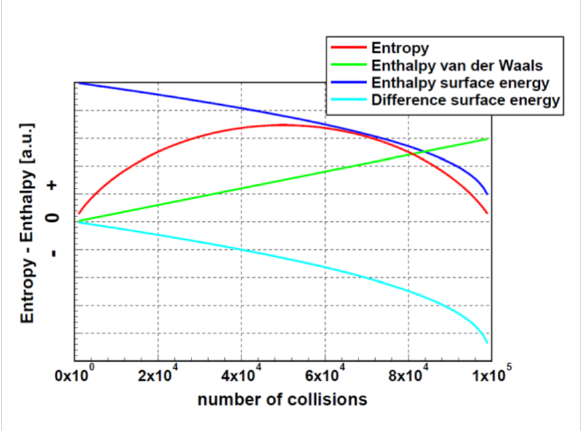
Figure 6: Entropy and enthalpy of agglomerated ensembles as func- tion of the number of collisions. This simulation was calculated for an ensemble of 10 5 particles. The enthalpies were calculated for the van der Waals interaction and the difference of the surface energy, accord- ing to Equation 5, assuming a complete agglomeration. It is important to realize that, in contrast to the entropy, the enthalpies do not show any local extremum. For clarity, the data for entropy and enthalpy are plotted in arbitrary units. Due to the large number of particles, fluctua- tions are, similar to Figure 4a, not